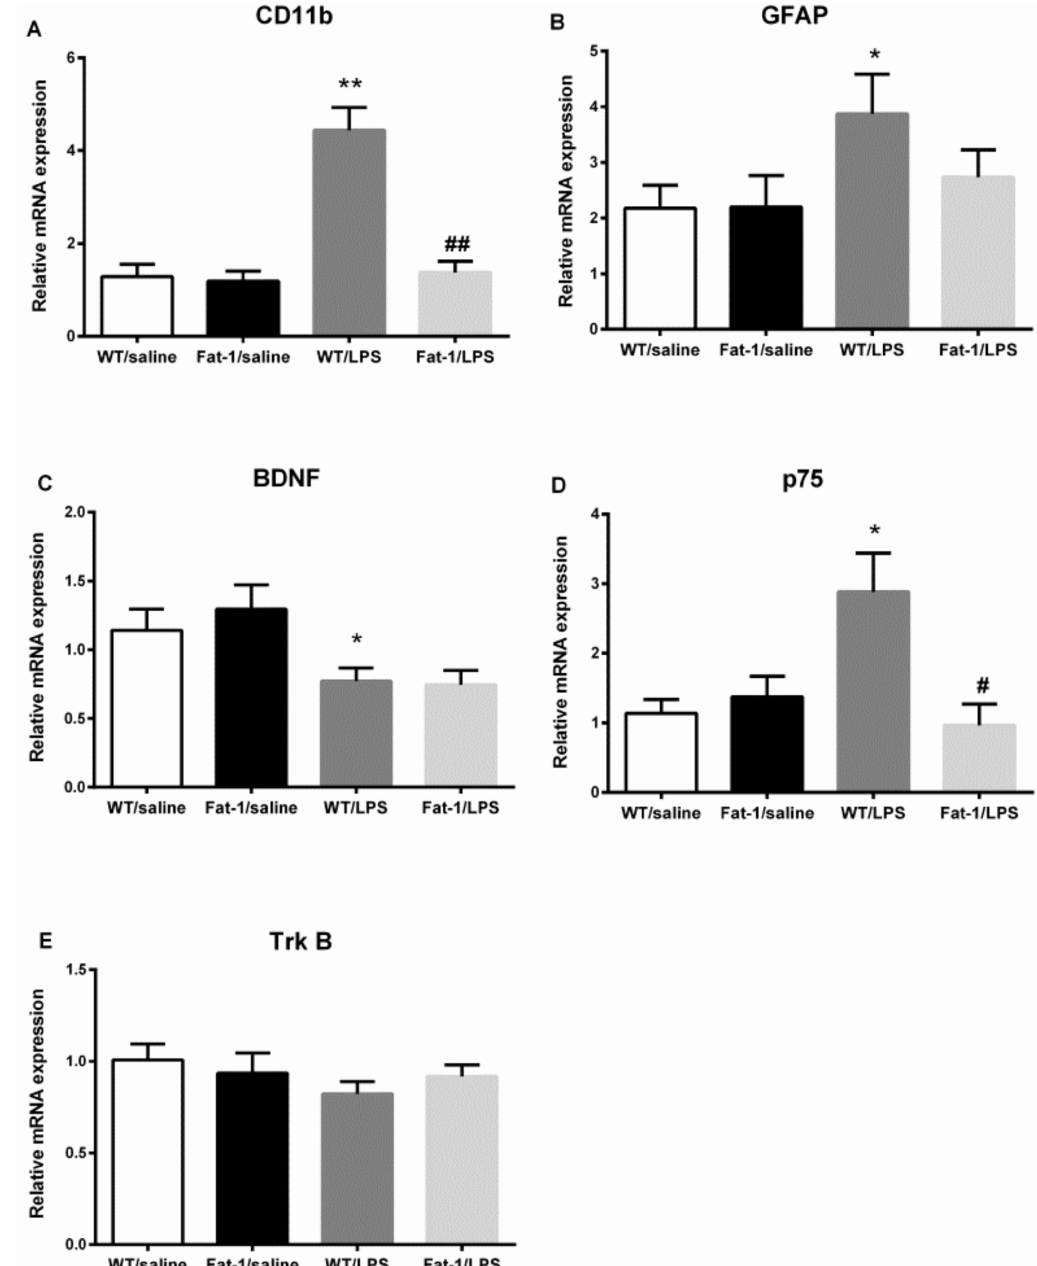
Figure 8. LPS up-regulated the mRNA expression of CD11b, GFAP, and p75, and down-regulated mRNA expression of BDNF in the LPS model. mRNA expression of CD11b and p75 were decreased in Fat-1 mice when compared with WT/LPS-challenged group. ( A ) CD11b; ( B ) GFAP; ( C ) BDNF; ( D ) p75; ( E ) Trk B. * p < 0.05, ** p < 0.01 vs. WT/saline; # p < 0.05, ## p < 0.01 vs. WT/LPS. GFAP: glial fibrillary acidic protein; BDNF: brain-derived neurotrophic factor; LPS: lipopolysaccharides; WT: